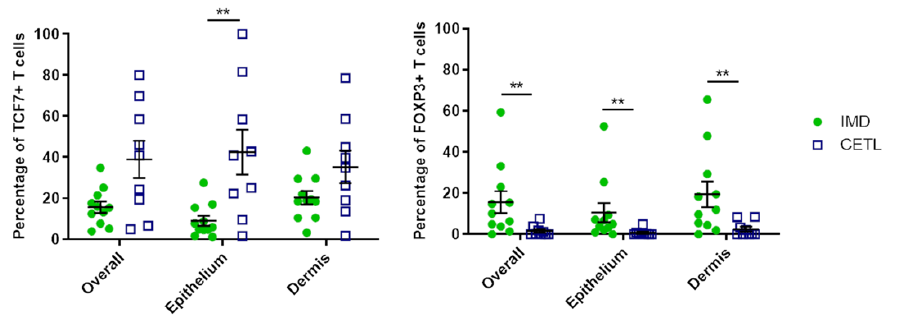
Figure 4. Results of the immunohistochemistry. Percentage of TCF7- and FOXP3-positive T-cells in the whole skin (overall), in the epithelial structures (epithelium) and the dermal portion (dermis); whiskers indicate the standard deviation of the mean; ** p < 0.05.